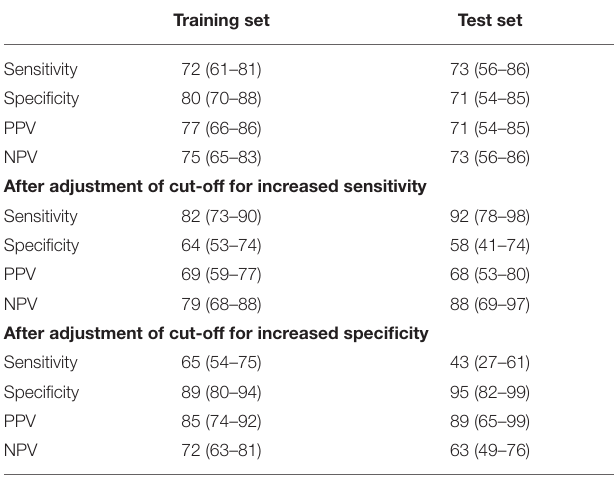
TABLE 6 | Performance of a new five-protein signature derived from Generalised Discriminant Analyses (GDA).